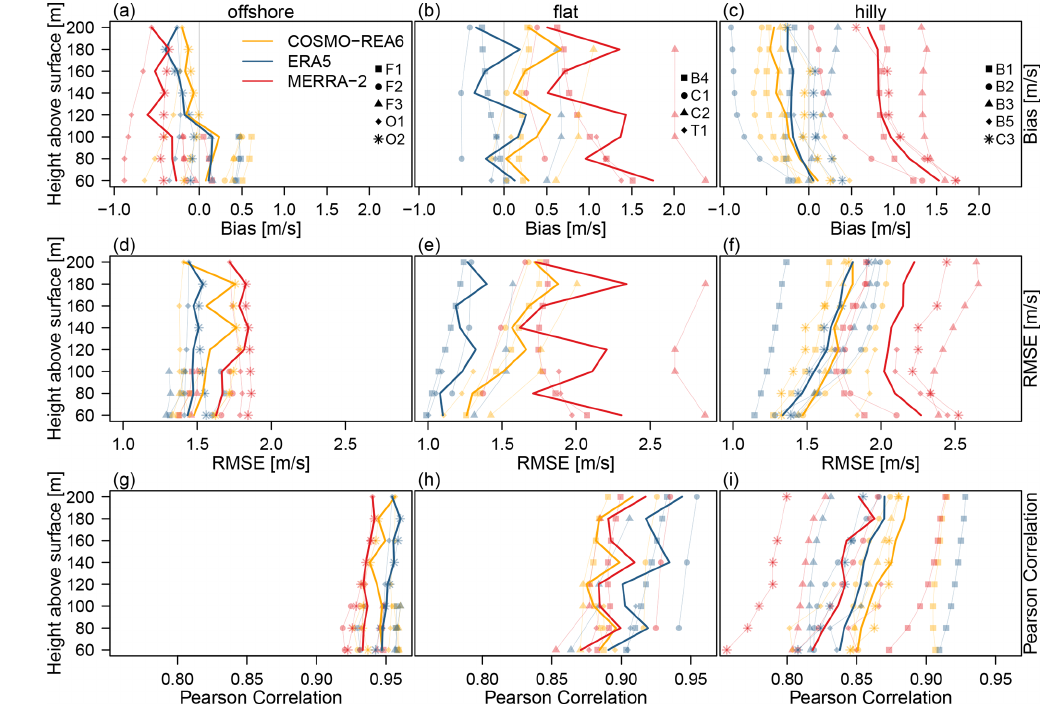
Figure 4. (a–c) Bias, (d–f) RMSE and (g–i) Pearson correlation between the reanalyses COSMO-REA6 (orange), MERRA-2 (red), ERA5 (blue) and the observed wind speed as a function of height. Symbols indicate the offshore locations (a, d, g) , flat (b, e, h) and hilly ter- rain (c, f, i) . Solid lines represent means over all observation